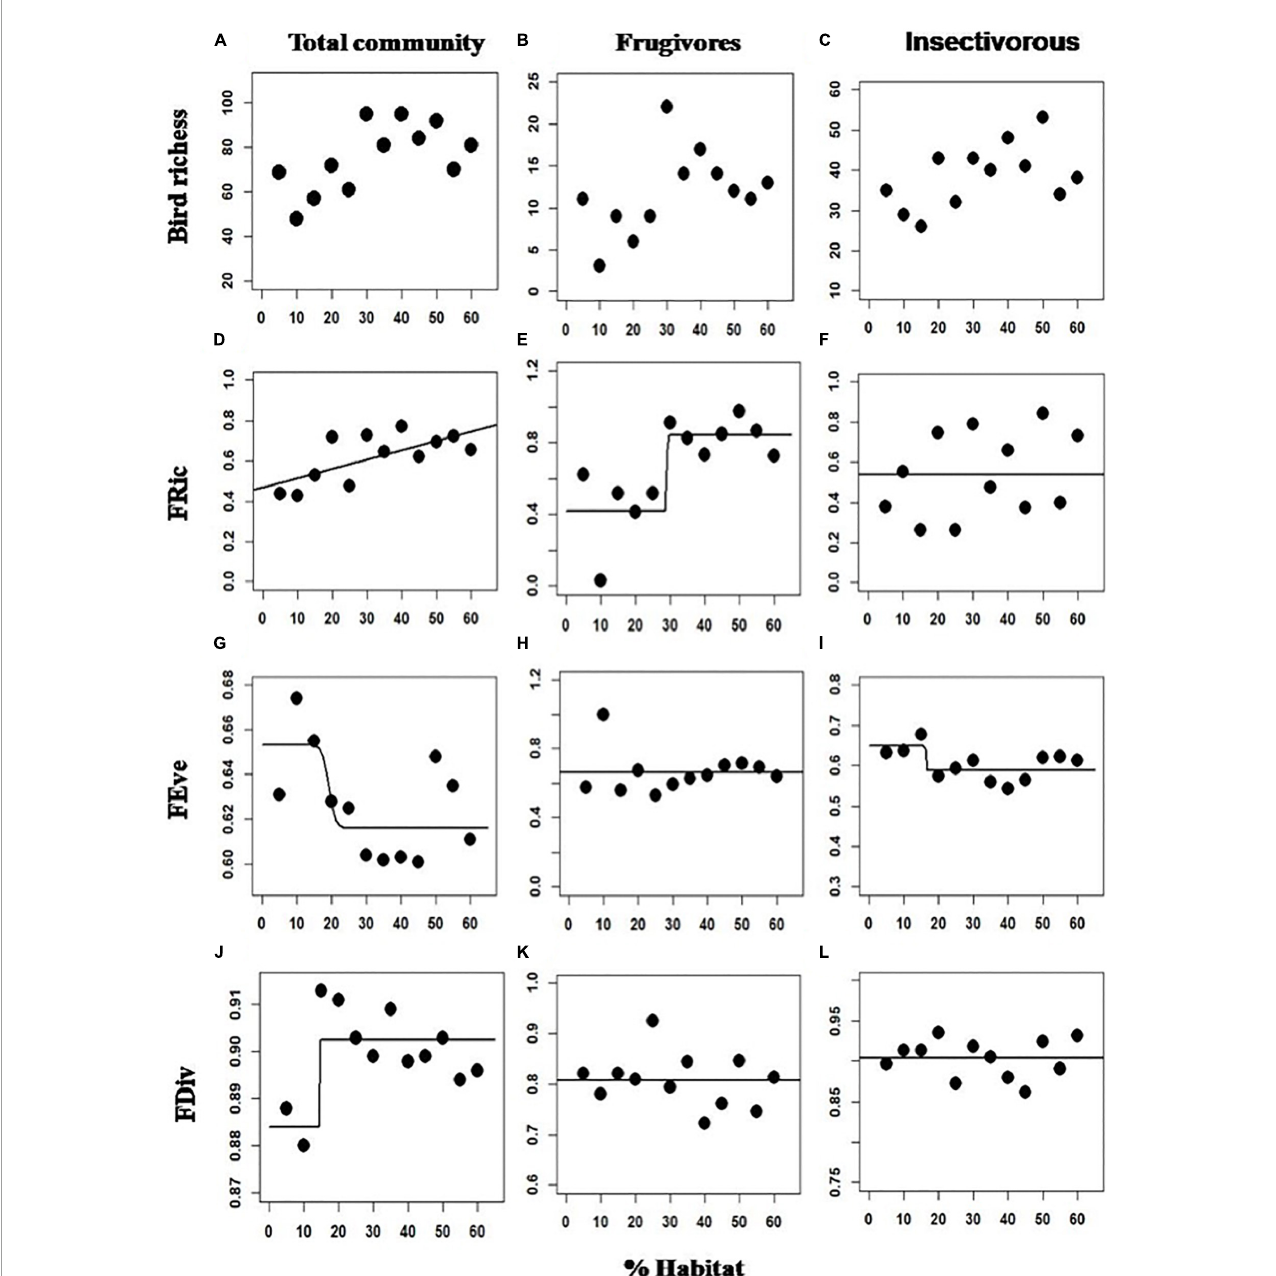
FIGURE2 Responses of functional diversity variables and species richness to habitat loss, rows represent responses of the species richness FRic, FEve, and FDiv metrics from different bird communities (columns). The total community (A,D,G,J) , Frugivores (B,E,H,K) , and Insectivorous (C,F,I,L) . Atlantic Forest of Bahia, Northeast